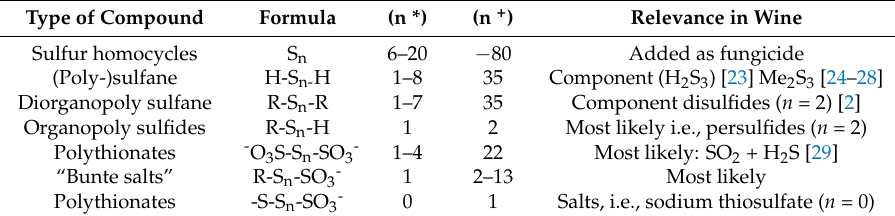
Table 1. Presently-known sulfur rings and chains (n represents the chain length or ring size). Type of